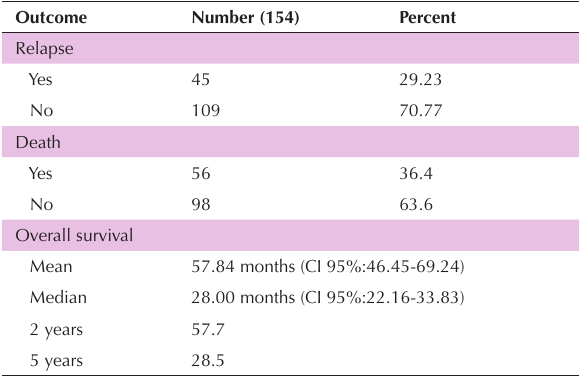
Table 1. Survival rate in gastric cancer